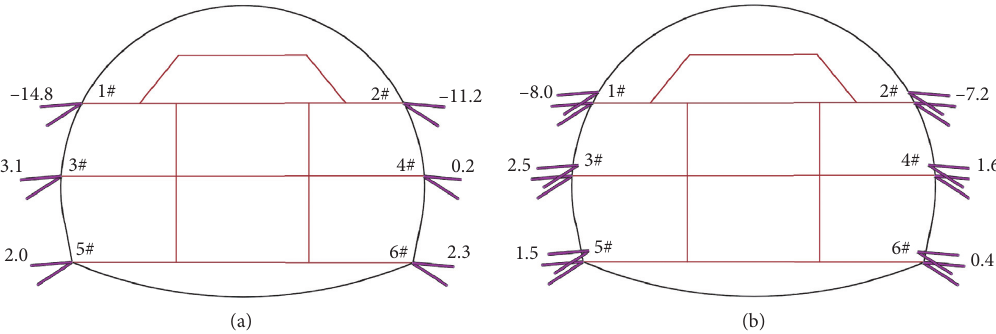
Figure 26: Installation of drawing of feet reinforcement bolt axis dynamometer.